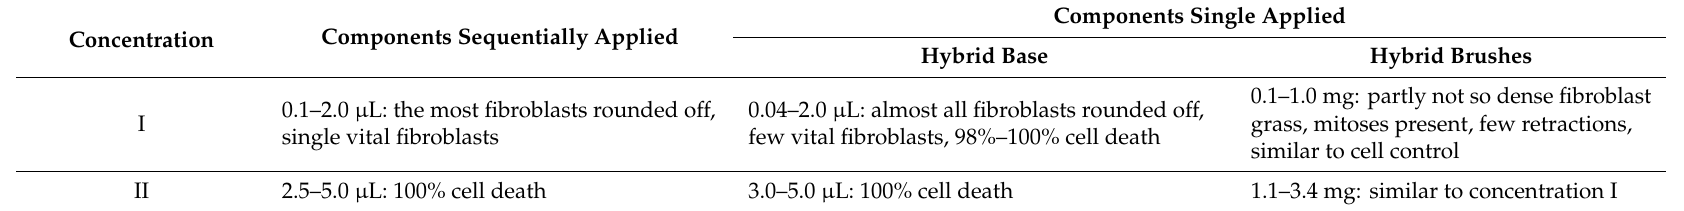
Table 4. Qualitative evaluation: hybrid bond (No. 1).